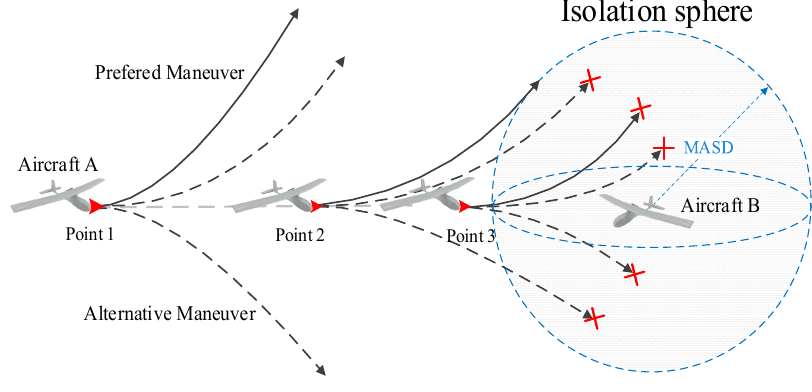
Figure 4. The moment to activate the maneuver.